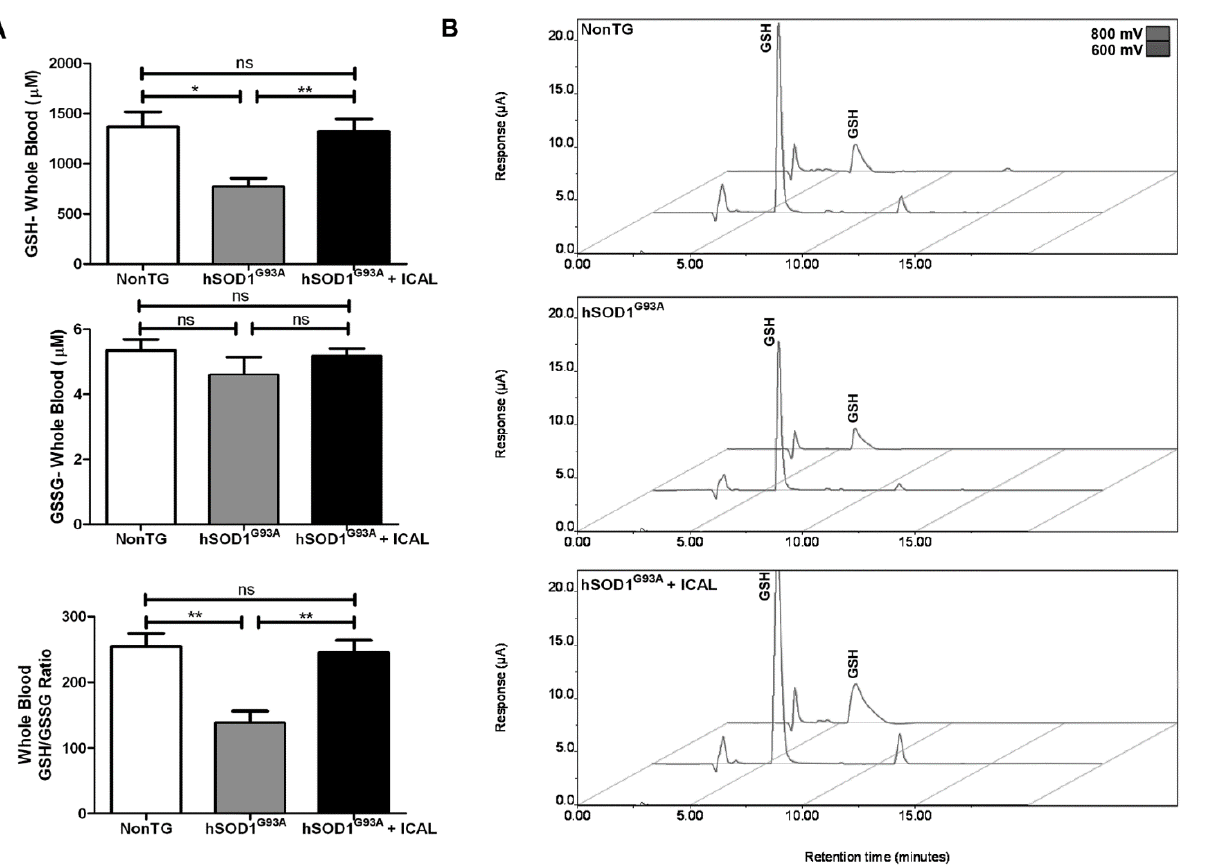
receiving Immunocal ® . ( A ) Mean GSH and glutathione disulfide (GSSG) concentrations and GSH/GSSG ratios from the whole blood of end-stage trial animals determined using HPLC-EC detection, n = 13. ** indicates p < 0.01; * indicates p < 0.05; ns indicates no significant difference. ( B ) Representative HPLC-EC chromatograms from the whole blood of end-stage animals; labeled peaks indicate GSH oxidizing at 600 and 800